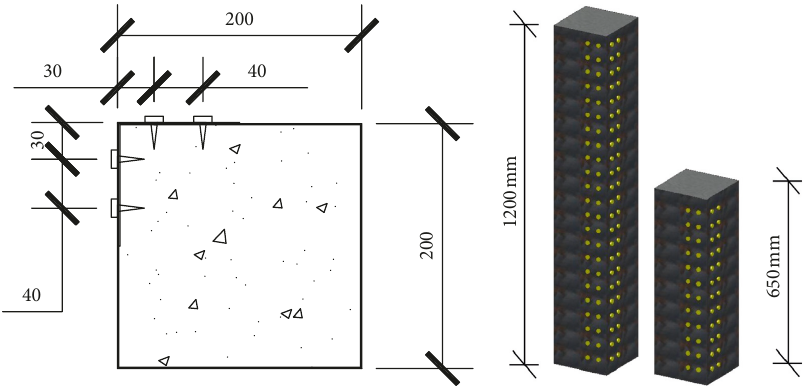
Figure 3: Specimen